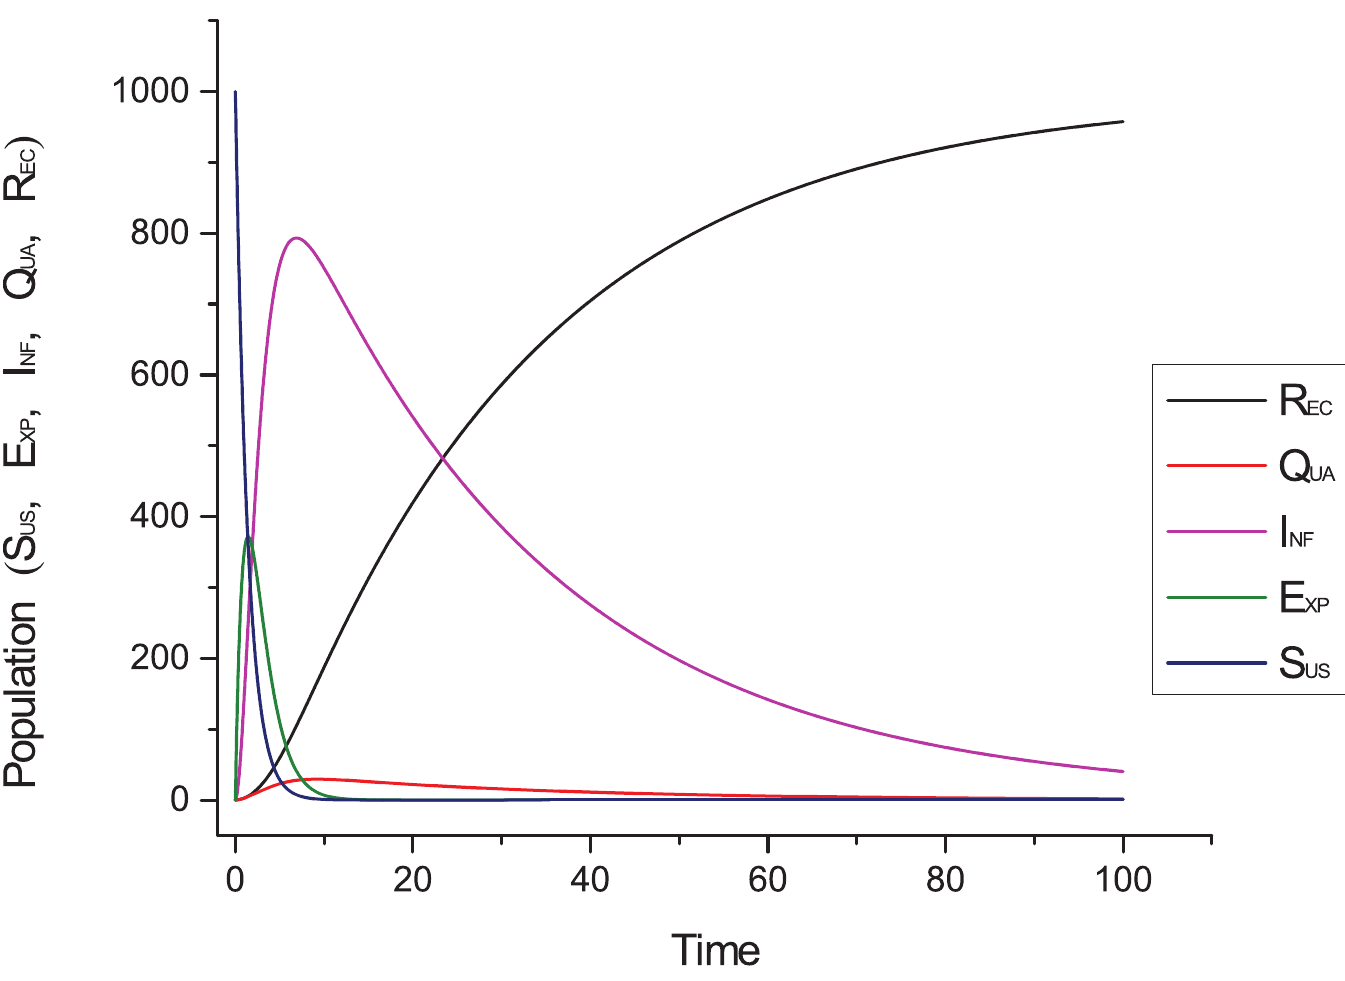
Fig 7. Dynamical behaviour of the proposed